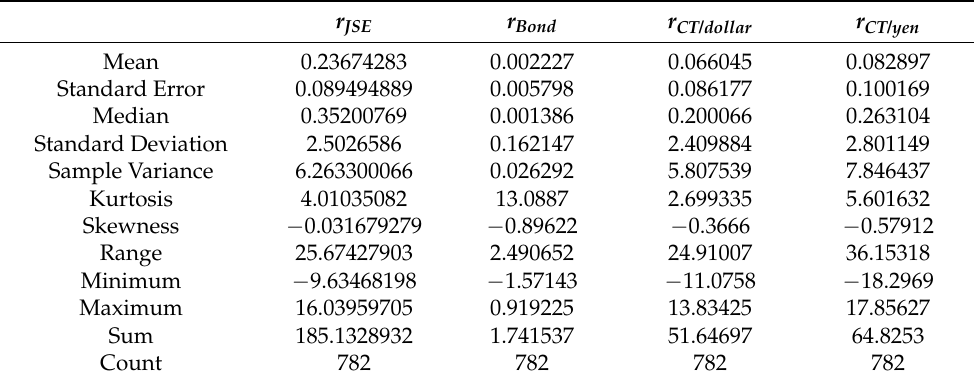
Table 1. Descriptive statistics for different returns series.